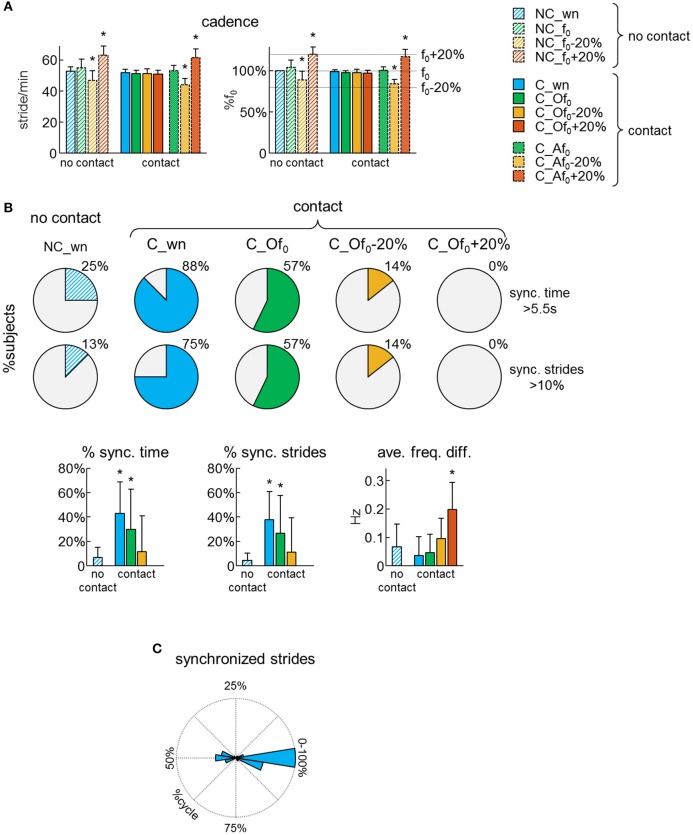
Dyad's synchronization. (A) Average (+SD) cadence expressed in stride/min (left panel) and as a percentage of the natural stride frequency (f0) of each subject (right panel) across different conditions (see Table 2 for the abbreviations). (B) Pie charts illustrating, for each condition, the percentage of subjects (n = 16), which experienced synchronized gait with the partner for at least 5.5 s (upper pies) or at least 10% of strides (lower pies). At the bottom: averaged (+SD) percent of time of synchronized (sync.) locomotion (left), percent of synchronized strides (middle) and average frequency difference of the contact side leg movements of the two partners (right) across different conditions. Asterisks denote significant (Dunnett's post-hoc test p < 0.05) differences with the normal (no contact) walking condition (NC_wn). (C) Polar histogram illustrating the distribution of the phase shift between contact side leg movements (Δφ) for the synchronized strides.